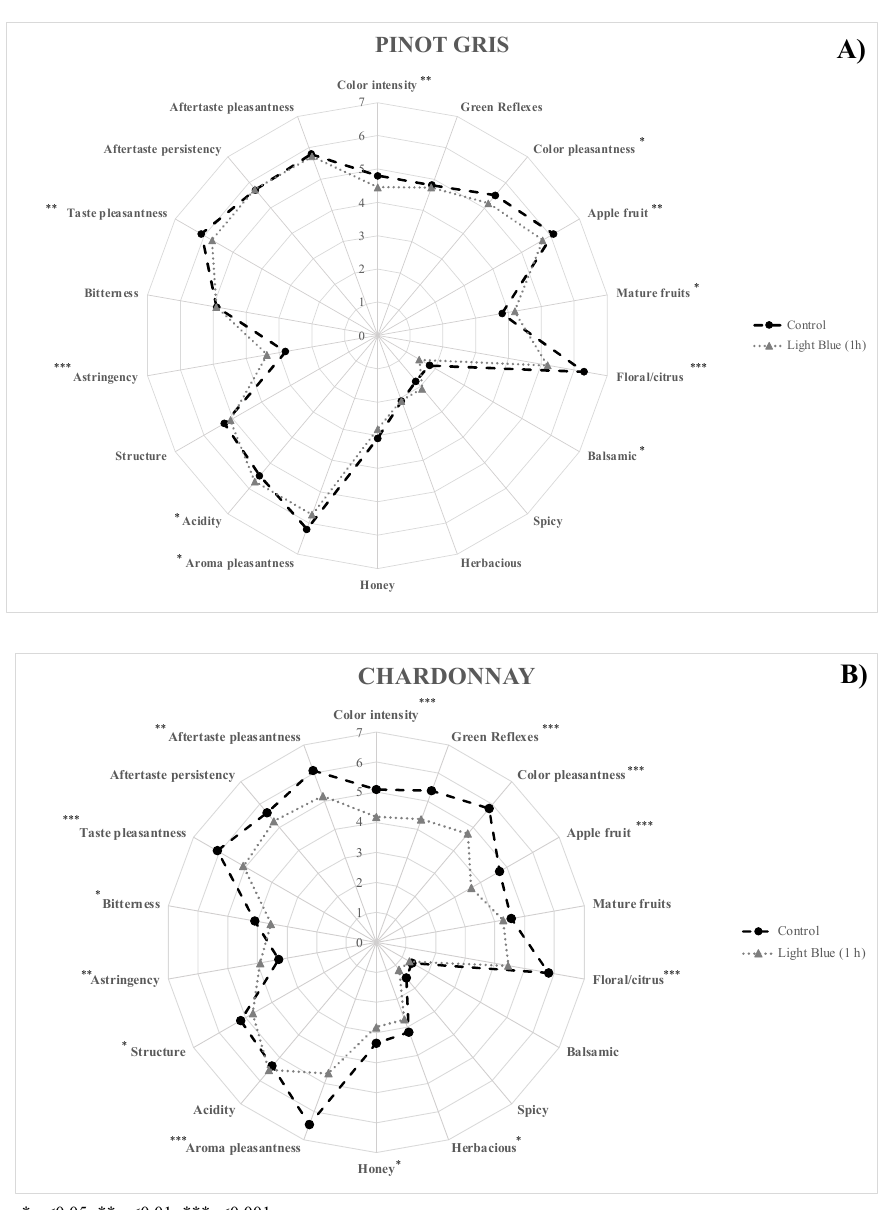
Figure 2. Sensorial analysis of Pinot Gris ( A ) and Chardonnay ( B ) wine before (Control) and after 1 h exposure to blue light.